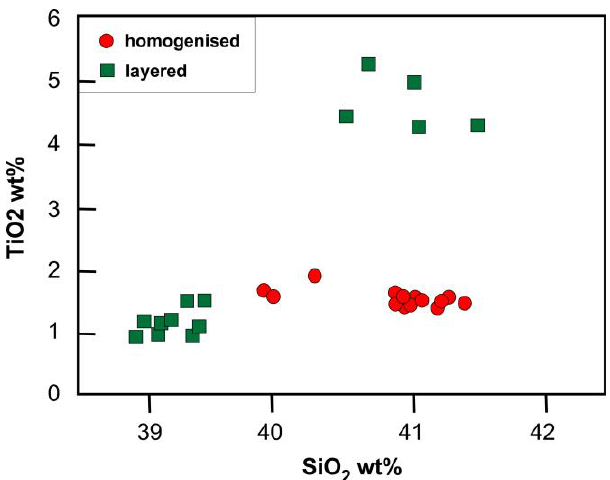
Figure 7. Comparison of phlogopite compositions in layered experiment G131 (green squares) to those in homogenized experiment G141 (both experiments were conducted at 3 GPa, 1100 °C). This shows that minerals from experiments in which lamproite and peridotite are mixed before the experiment (G141) are not equivalent to reaction products in the peridotite section of layered runs.